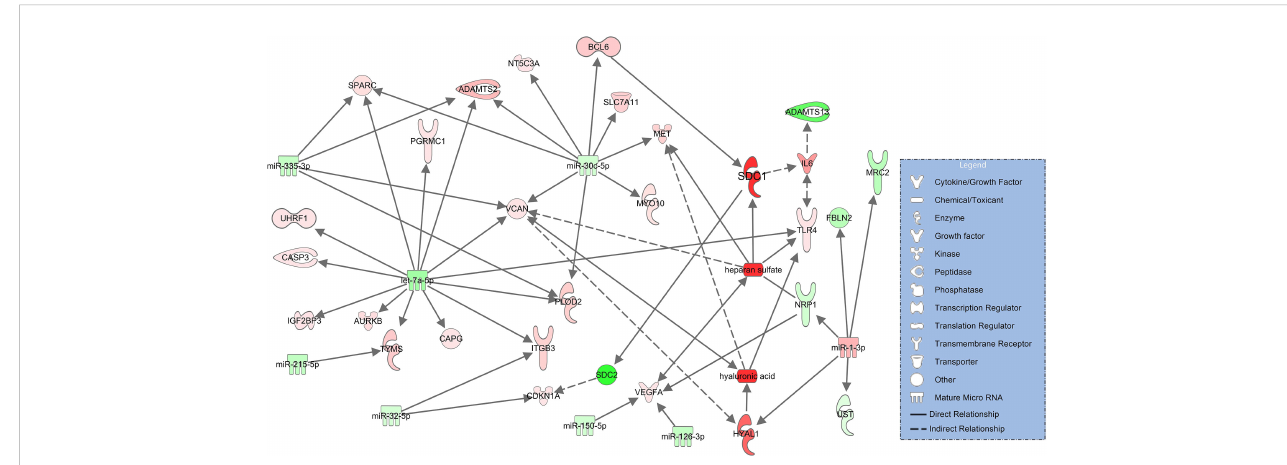
FIGURE 4 Network for immune and endothelial cells comparing COVID-19 ARDS to the healthy state based on experimentally observed fi ndings. Upregulated molecules are shown in red and downregulated ones in green. Signi fi cantly increased plasma concentrations of hyaluronic acid, heparan sulfate, syndecan-1 (SDC1) and downregulated signaling of ADAMTS13 are colored in darker red/green. Solid lines indicate direct and dashed lines indirect